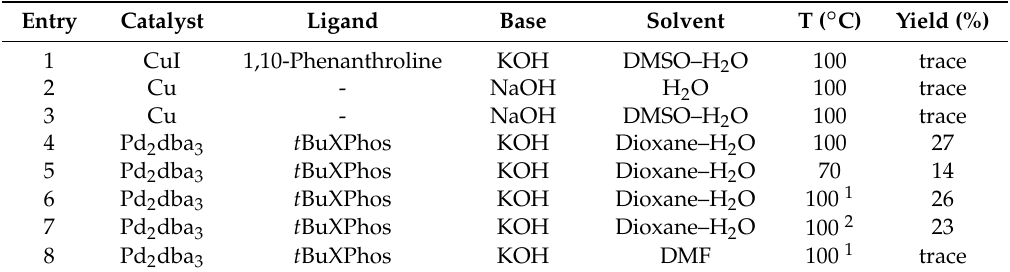
Table 1. Attempts towards the oxidation of aryl halide 13 .